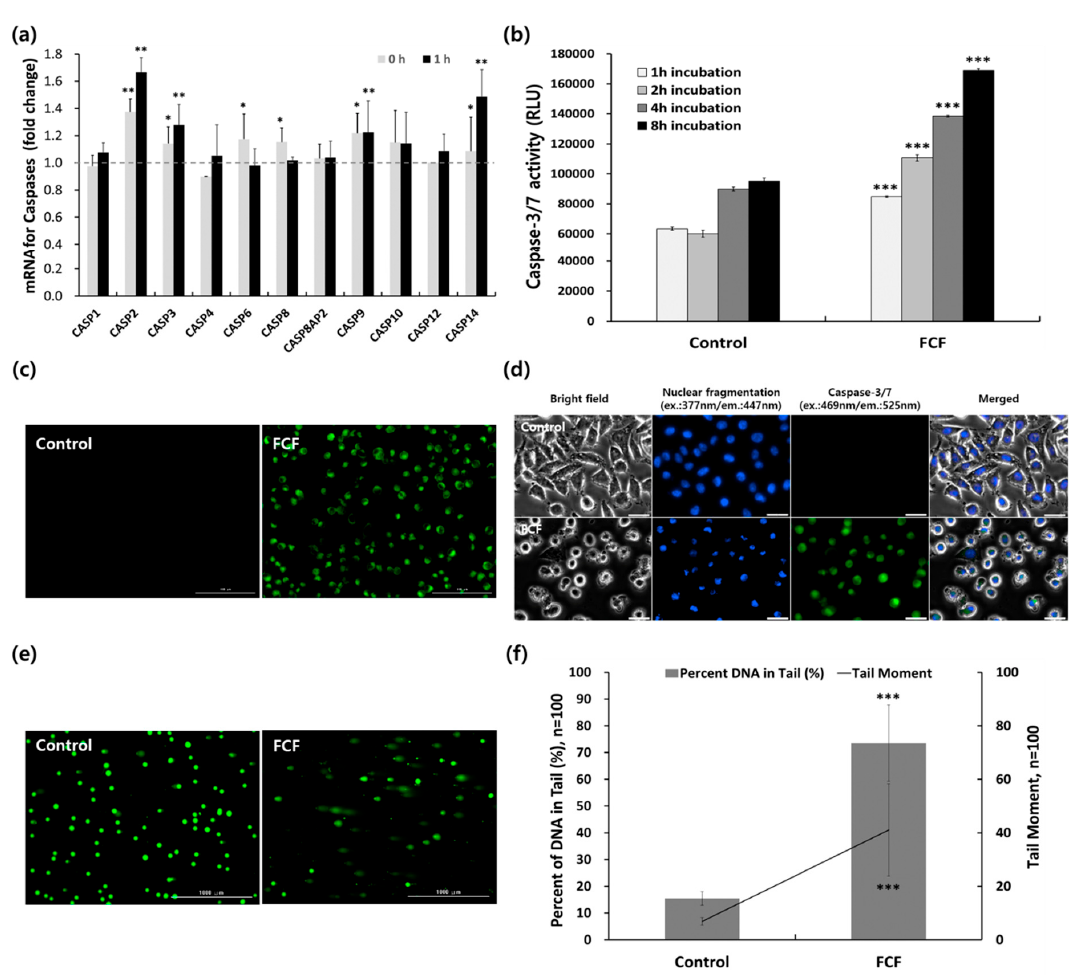
Figure 7. Apoptotic cell death induced by FCF NPs in HeLa cells . ( a ) Caspase mRNA expression was analyzed by Ampli-Seq sequencing after 40 mW PDT for 10 min and incubation for 0 and 1 hr. ( b ) Caspase-3/7 activity over the duration of post-PDT incubation was detected using a Caspase-Glo 3/7 assay kit. HeLa cells were tested 1, 2, 4, and 8 h after 40 mW PDT for 10 min. Data are expressed as mean ± S.D. (n = 4), and statistical significance was set at p < 0.05 (*** p < 0.0005 vs. control). ( c ) Phosphatidylserine translocation in HeLa cell membranes was stained with fluorescein isothiocyanate (FITC)-conjugated Annexin V (Annexin V-FITC) dye 4 h after 40 mW PDT for 10 min. The green fluorescence signal was produced by Annexin V-FITC. FCF: Fe3O4-Ce6-FA NPs. Scale bar = 100 µm. ( d ) Nuclear fragmentation and Caspase-3/7 activity in HeLa cells. HeLa cells were stained with Hoechst 33342 dye to detect nuclear fragmentation. Caspase-3/7 Green Detection reagent was used to detect Caspase-3/7 activity 4 h after 40 mW PDT for 10 min. Scale bar = 30 µm. ( e ) HeLa cell DNA damage was identified using an alkaline comet assay for detecting DNA damage. ( f ) The percentage of DNA in the tail and tail moment. Quantitative data are expressed as mean ± S.D. (n =